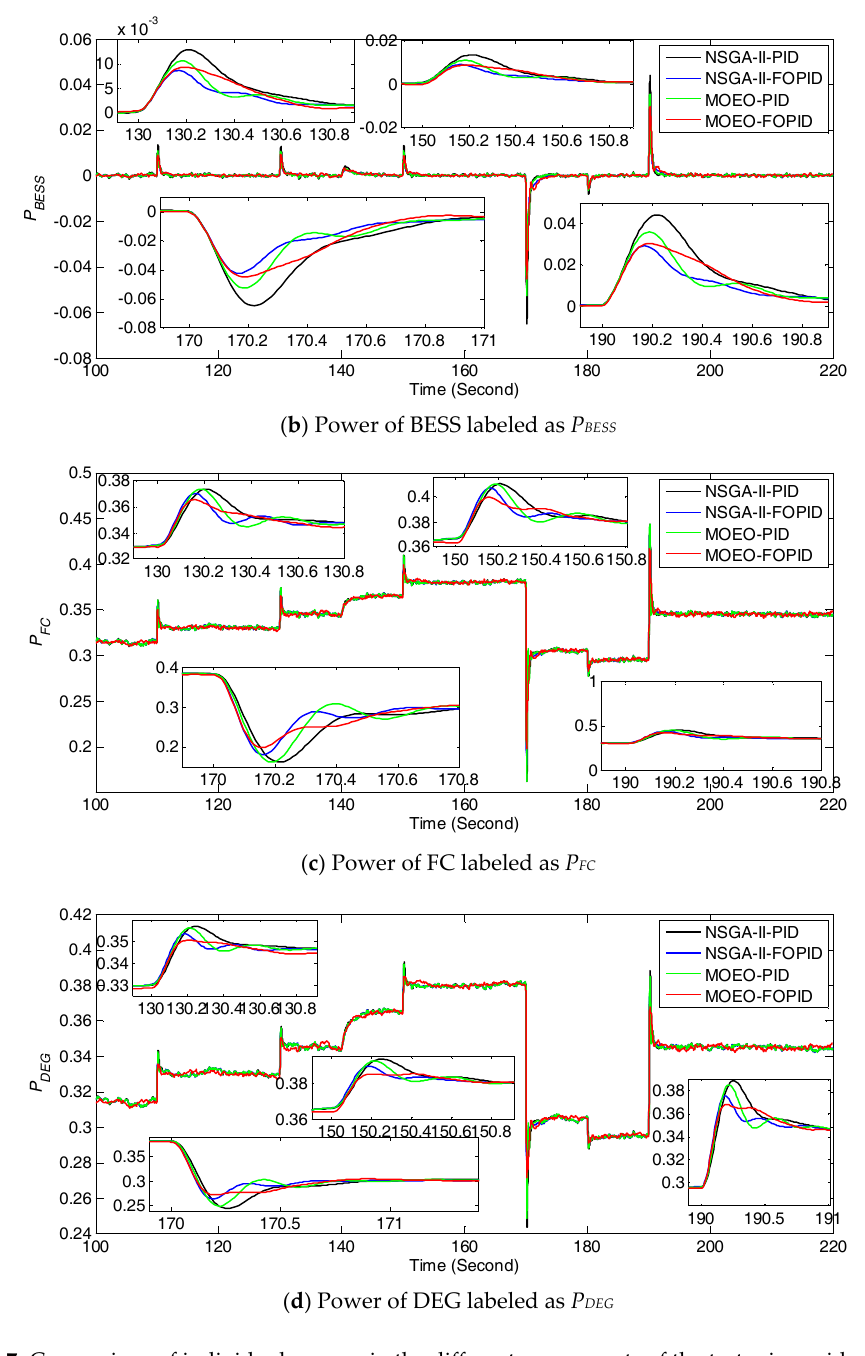
Figure 7. Comparison of individual powers in the different components of the test microgrid with the best FOPID/PID controllers obtained by the NSGA-II and MOEO algorithms.